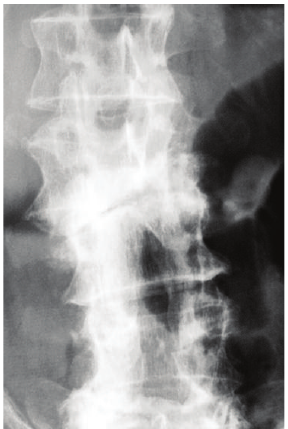
Figure 1: Anteroposterior radiographs showing marked narrowing of L2-L3 disc space with some endplate destruction associated with new bone formation and a severe lateral dislocation of the L2/L3 joint (Case 1).